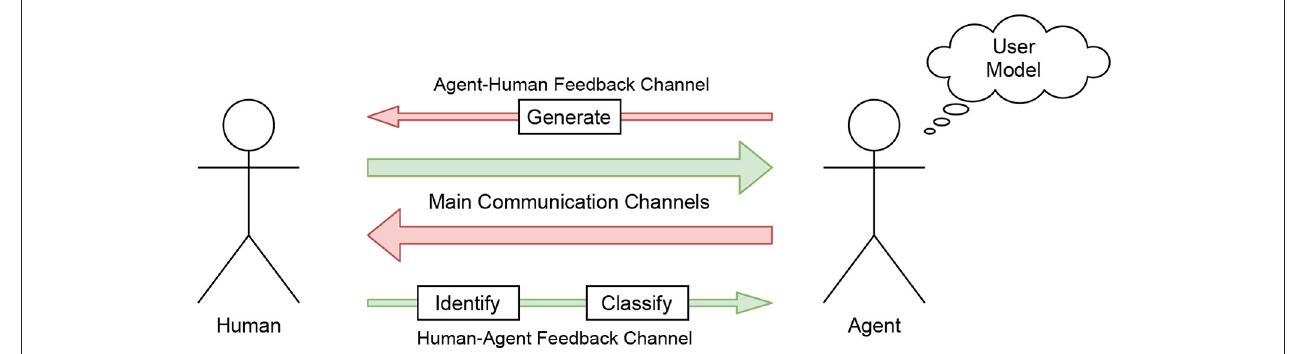
FIGURE 1 | An abstract representation of how feedback-aware and feedback-generating systems